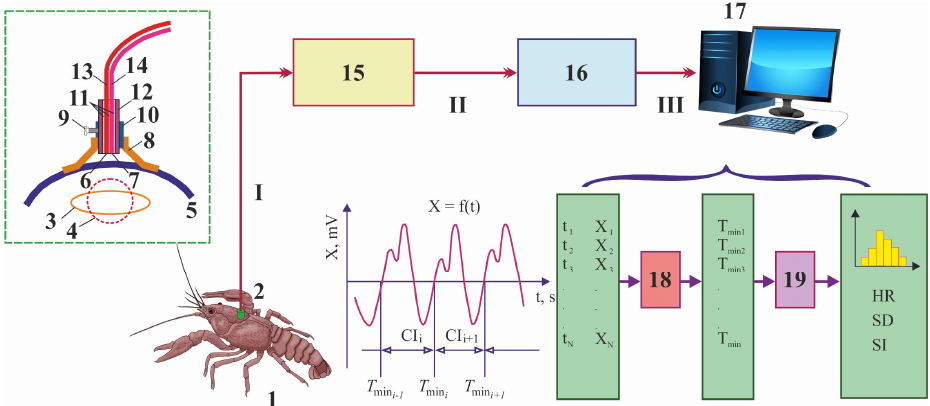
Figure 4. Scheme of the cardiac activity registration system developed in Saint ‐